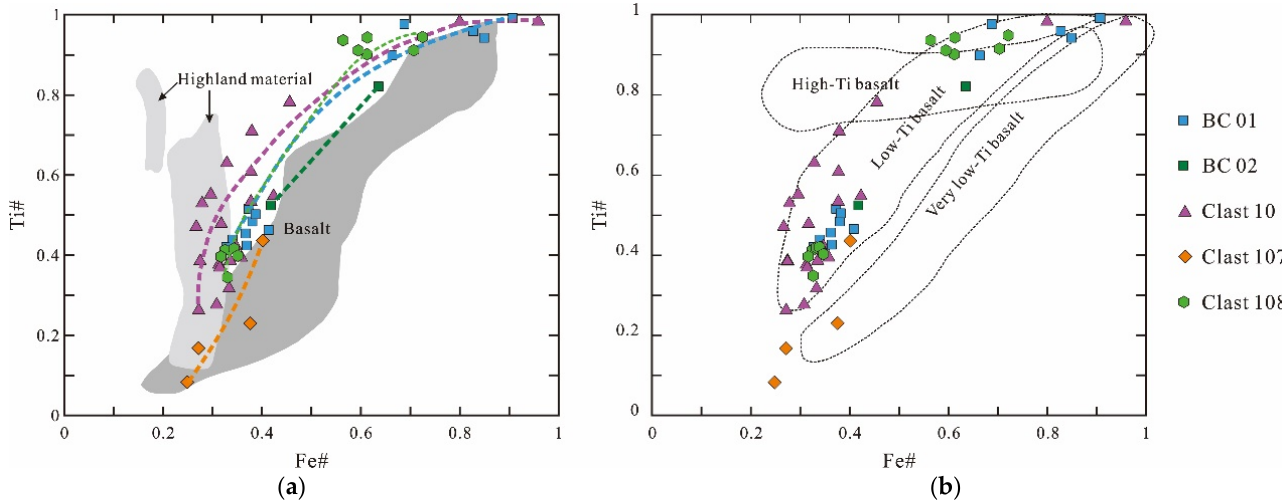
Figure 10. Ti # (Ti/(Ti + Cr)) vs. Fe # (Fe/(Fe + Mg)) of pyroxene in NWA13120 clasts. ( a ) The relationship between pyroxene in NWA 13120 and basalt and highland material, where the dotted line is the trend of pyroxene composition in different clasts, and the division of highland material and basalt area is according to [38,39]. ( b ) The relationship between pyroxene in NWA 13120 and basalt with high-Ti, low-Ti, and very low-Ti, the division is according to [40,41].